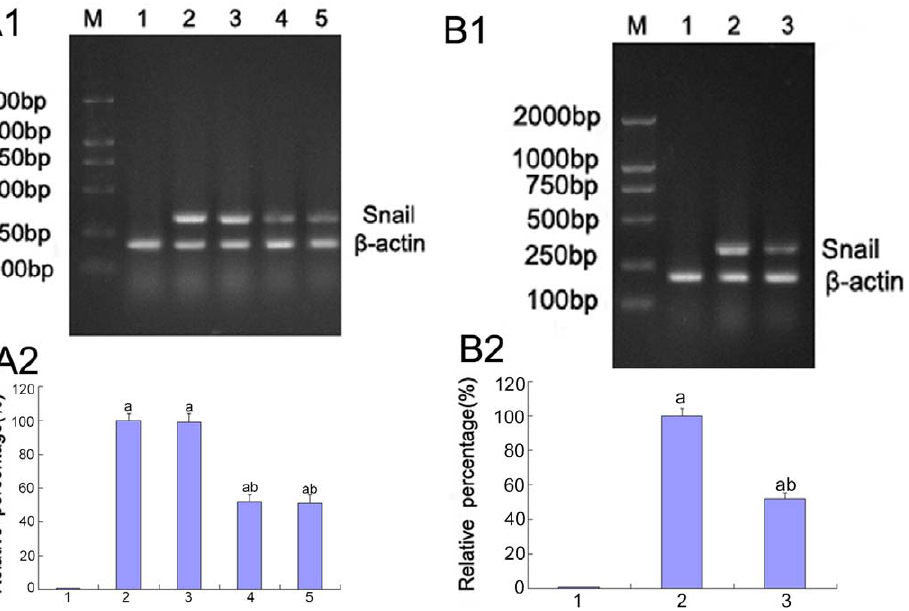
Figure 13. The expression of Snail mRNA in HK-2 cells by RT-PCR. (A)The levels of Snail mRNA were detected by RT-PCR of the HK-2 cells cultured in 5.5 mM glucose (lane 1), 30 mM glucose (lane 2), 30 mM glucose + Cont siRNA (lane 3), 30 mM glucose + p38 siRNA for 24 h (lane 4), 30 mM glucose DMEM + p38 siRNA for 48 h(lane 5).(B)The levels of the Snail mRNA were detected by RT-PCR of the HK-2 cells incubated in 5.5 mM glucose (lane 1), 30 mM glucose (lane 2), and 30 mM glucose + AP-1 inhibitor (lane 3). Values represent the mean 6 SD, aP , 0.05 vs. 5.5 mM glucose, bP , 0.05 vs. 30 mM glucose.